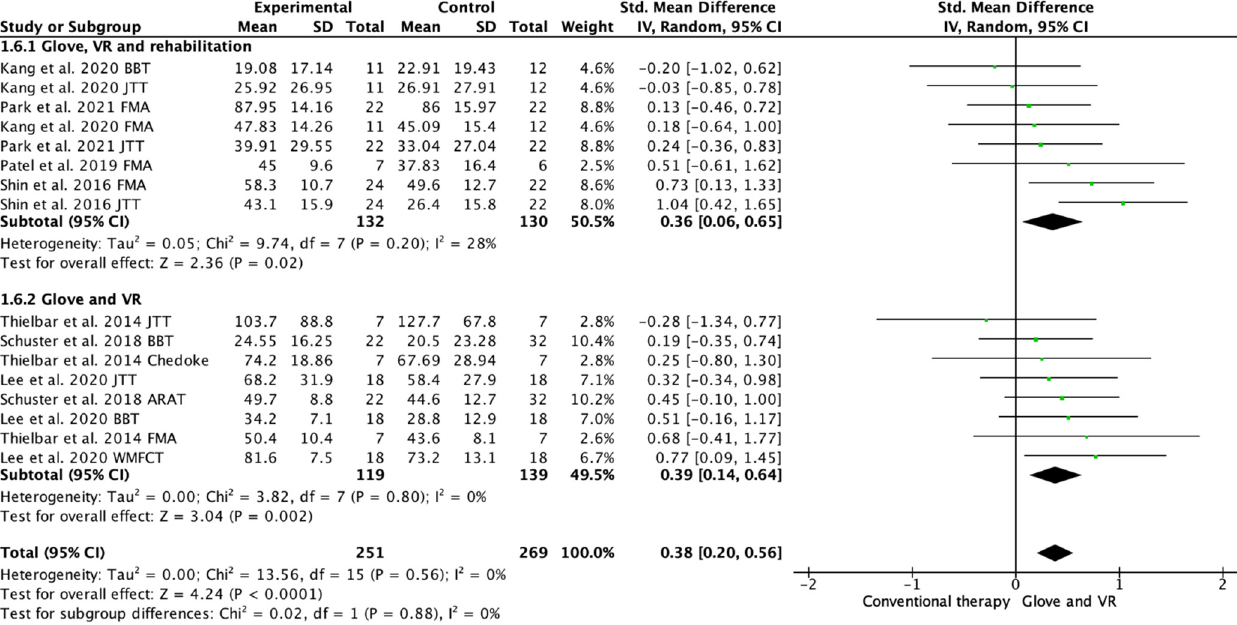
Figure 4. Forest plot of the results of a random-effects meta-analysis shown as standardized mean differences (SMD) with 95% confidence interval (CI) for short-term upper limb function assessment. Rehabilitation glove, combined with virtual reality and rehabilitation, and only rehabilitation glove, combined with virtual reality subgroups are reflected. The shaded square represents the point estimate for each individual study and the weight of the study in the meta-analysis. The diamond represents the overall mean difference of the studies [18–24].